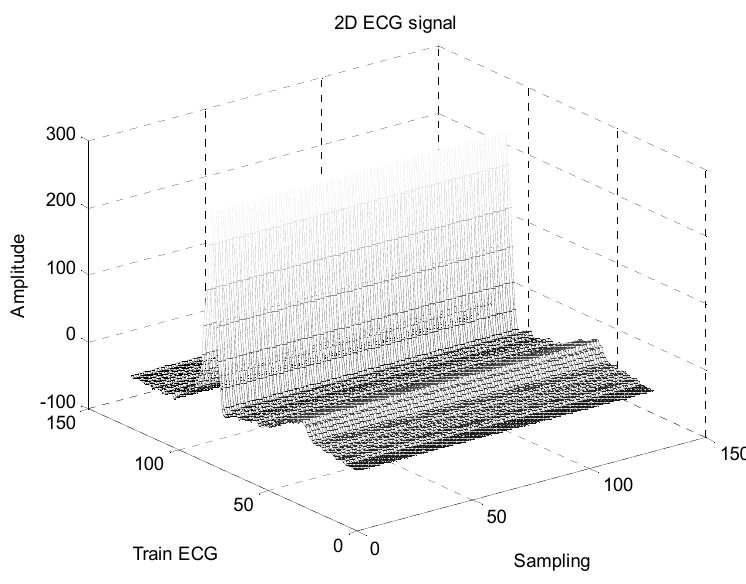
Figure 2. 2-DECG Figure 2. 2-DECG image. Figure 2. 2-DECG image.